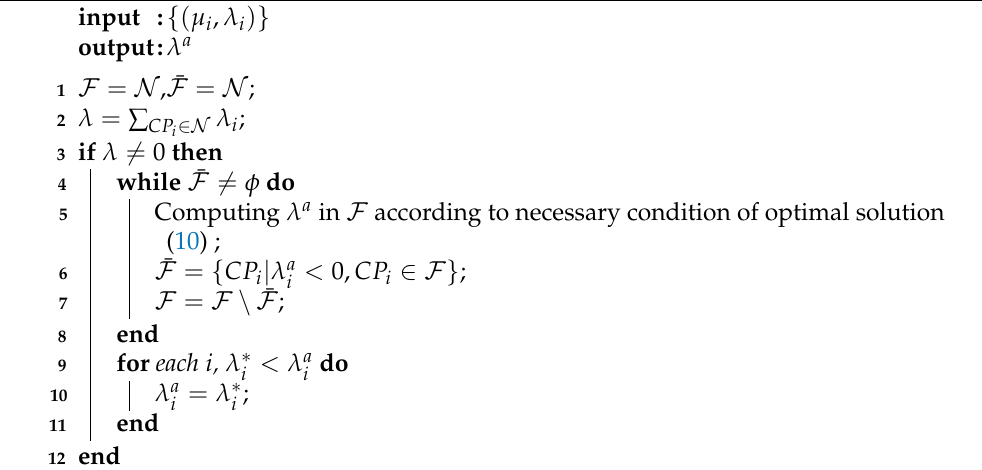
Algorithm 2: Service request allocation algorithm in